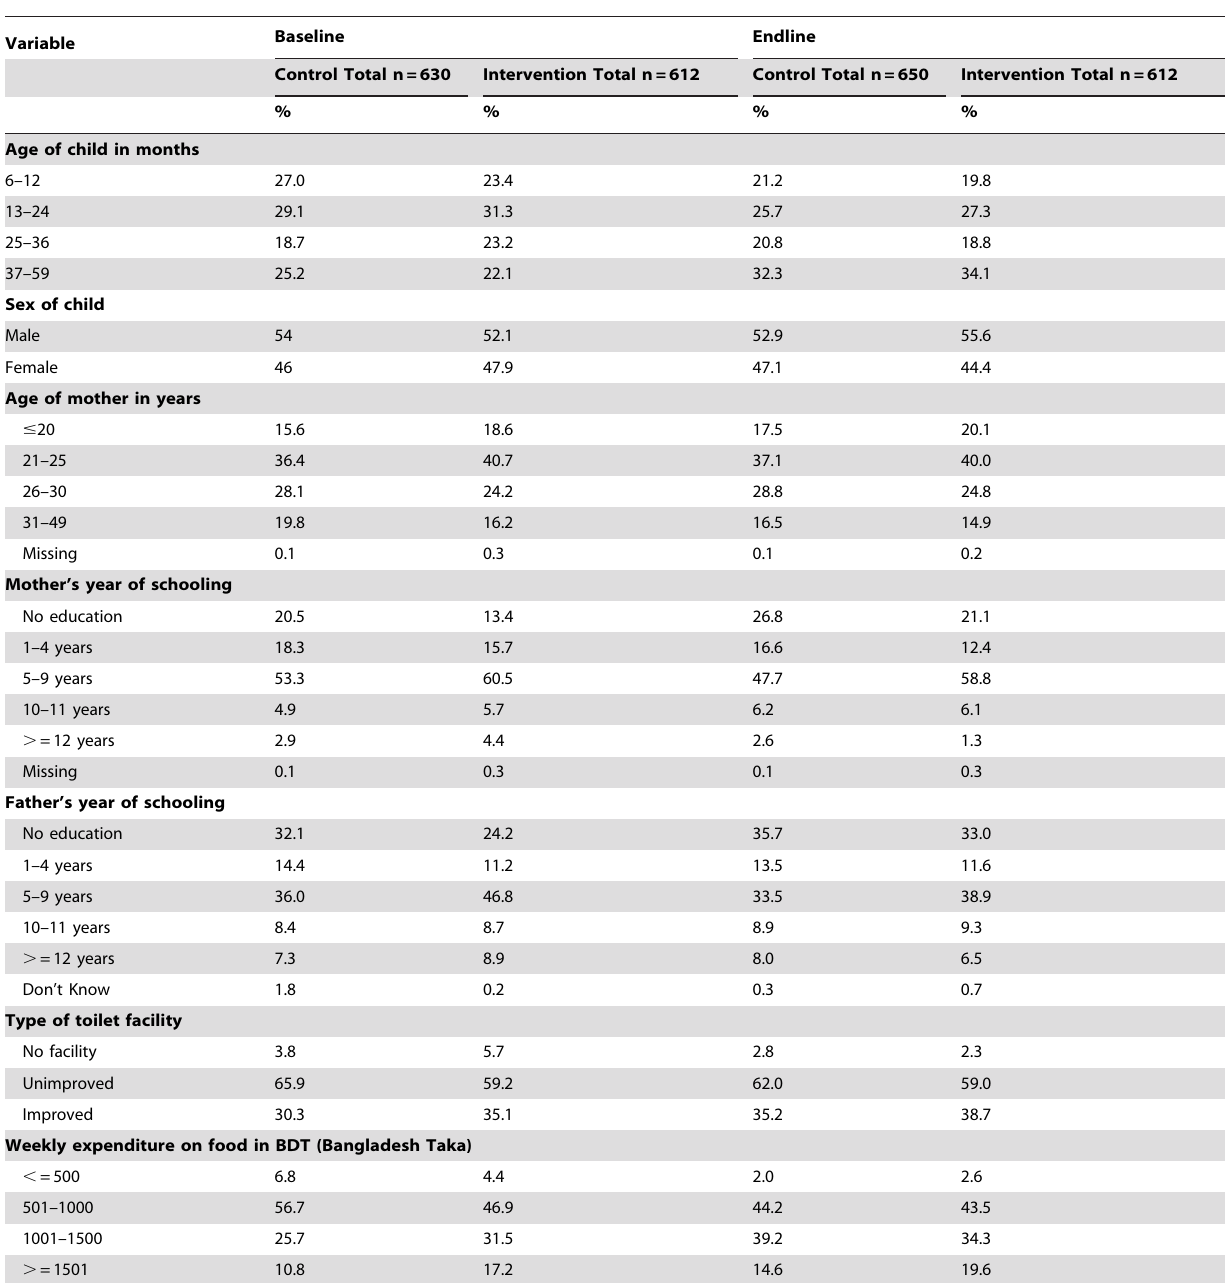
Table 2. Socio-demographic characteristics of the Control and Intervention areas.*